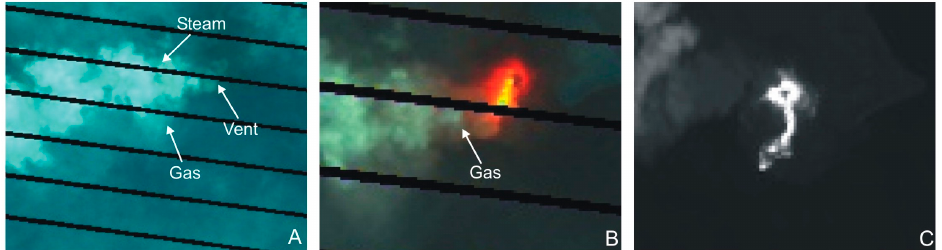
Figure 1. ( A ) Landsat ETM+ image RGB false color composite (band 4-3-2) of the Krakatau Volcano, 9 October 2018, showing an excess of gas and stema produced by intense degasification. ( B ) Landsat ETM+ image RGB false color composite (band 7-5-4) of the Krakatau Volcano, 9 October 2018, showing the black stripes caused by the SLC failure. ( C ) Landsat OLI band 7 of the Krakatoa volcano, 4 May 2015, showing the reset (value zero) of saturated pixels in the center of active lava flow.